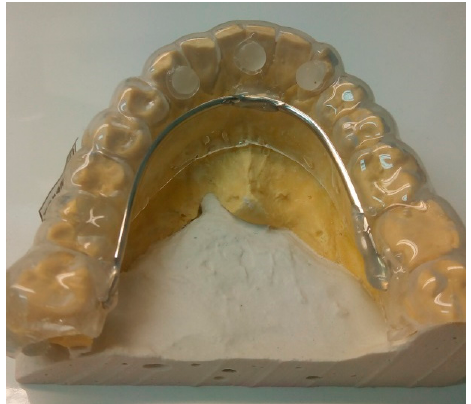
Figure 3. Reinforcement with wire steel and acrylic spheres.